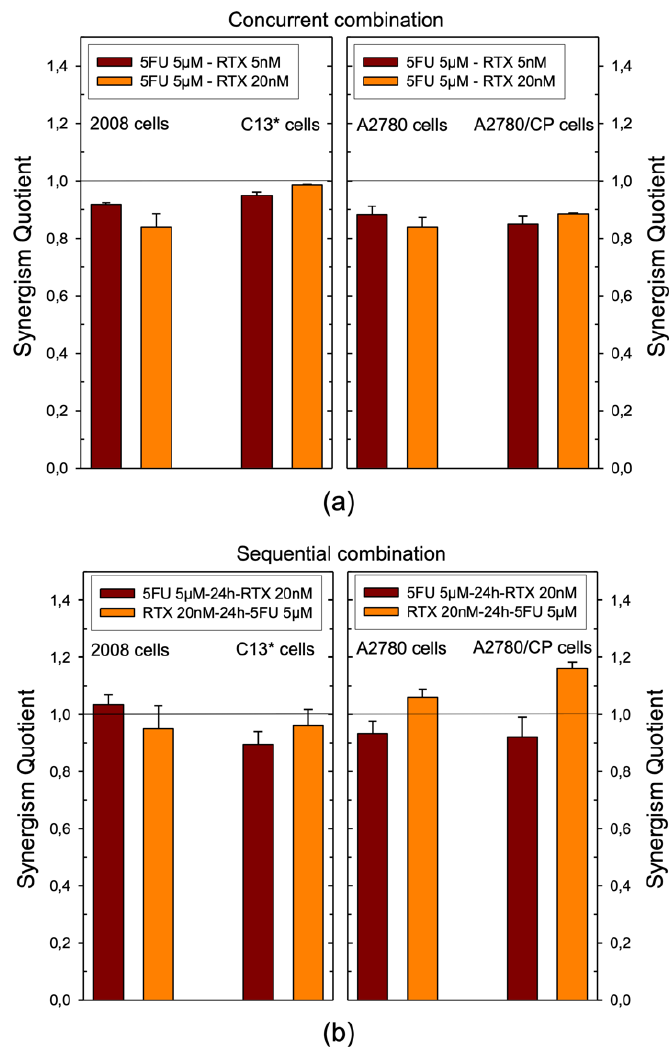
Figure 6. Synergism quotients for the inhibition of the growth of 2008, C13*, A2780, and A2780/CP cell lines caused by simultaneous ( a ) and sequential ( b ) administration of combinations of RTX and 5FU. Cell growth analysis was performed after exposing cells according to three schedules: simultaneous treatment (5FU/RTX), 5FU first, RTX 24 h later (5FU-24h-RTX), and the opposite (RTX-24h-5FU). The bars represent the mean of duplicate cell counts on three separate experiments. A quotient > 1 indicates synergism, =1, additivity <1 antagonism. Error bars represent SEM. The RTX:5FU 1:1000 (5 nM:5 µ M) concentration ratio produced antagonistic effects with both administration sequences (data not shown). On the contrary, when the two RTX followed by 5 μM 5FU on A2780 and A2780/CP cells.